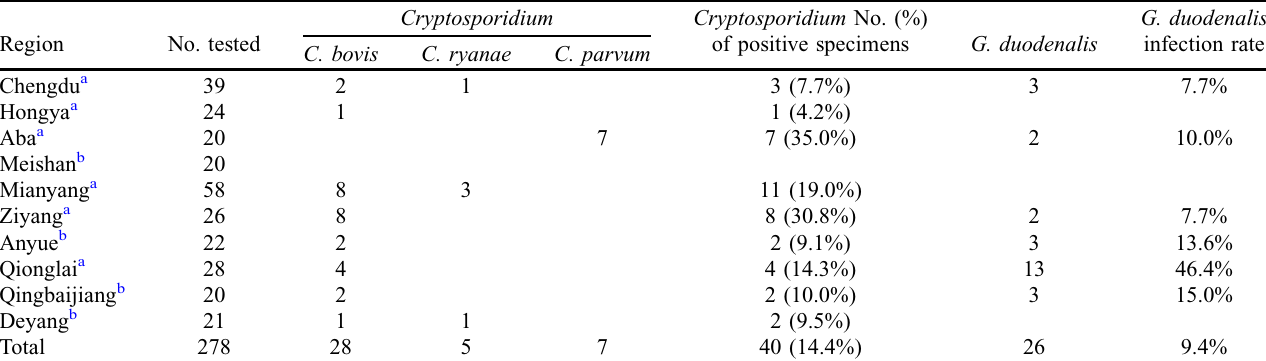
Table 1. Prevalence of Cryptosporidium and G. duodenalis in pre-weaned diary calves in Sichuan province.